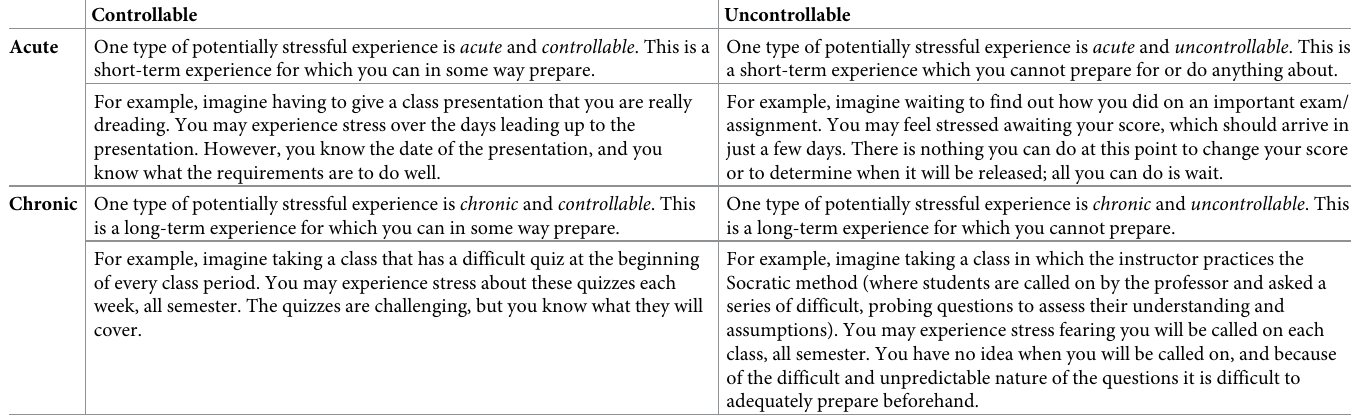
Table 1. Specific stress mindset hypothetical situations for acute controllable, chronic controllable, acute uncontrollable, and chronic uncontrollable mindset. Controllable